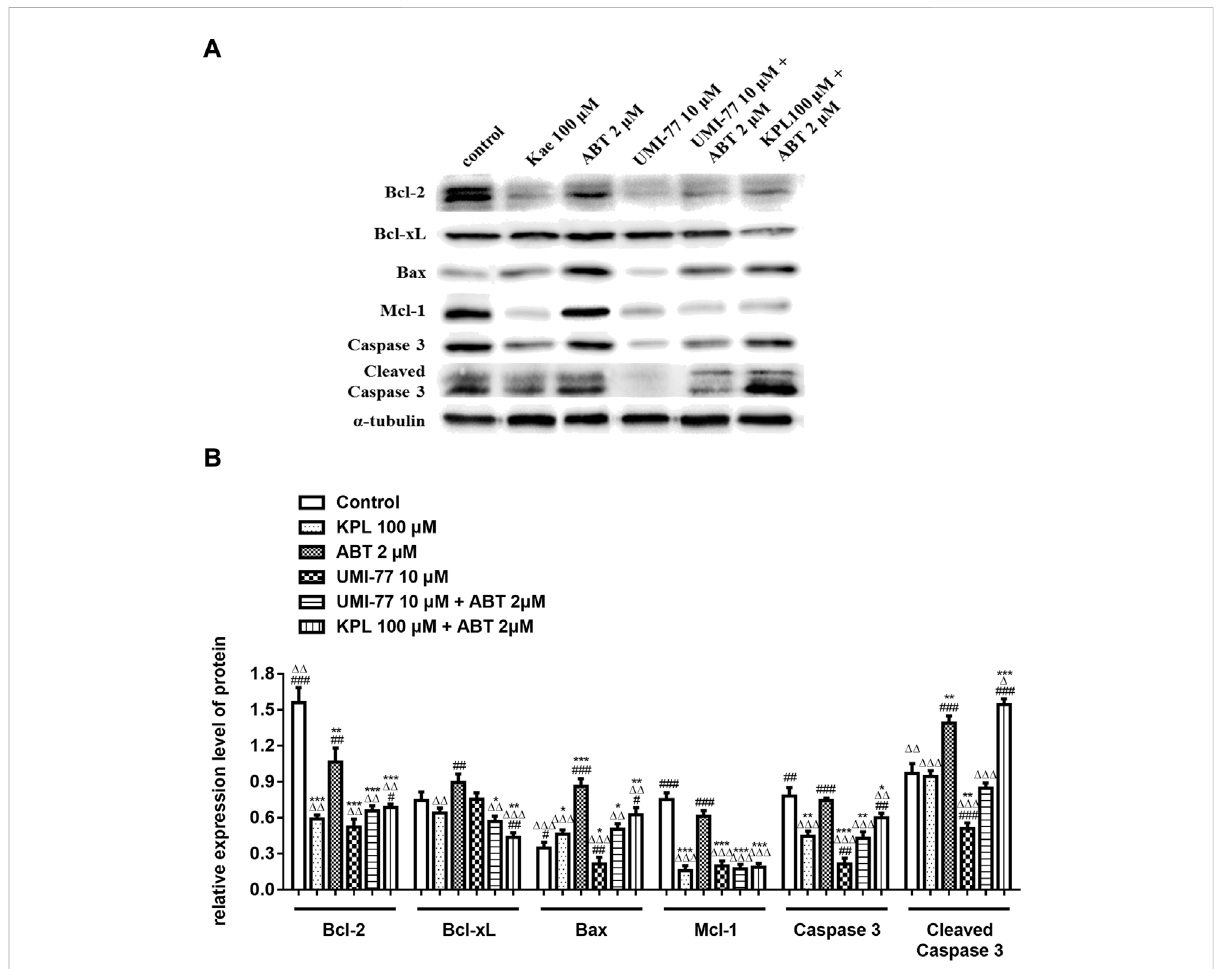
The effects of KPL combined with ABT-199 on caspase-3, cleaved caspase-3, Bcl-2, Bcl-xL, Bax and Mcl-1 proteins in HepG2 cells. (A) The expression levels of Bcl-2, Bcl-xL, Bax, Mcl-1, caspase 3 and cleaved caspase 3 were examined by western blotting analysis. α -tubulin was used as internal control. (B) The relative expression level of Bcl-2, Bcl-xL, Bax, Mcl-1, caspase-3 and cleaved caspase-3. α -tubulin was used as internal control. Relative expression of target protein = expression of target protein/expression of internal control protein. Values are means ± SD ( n